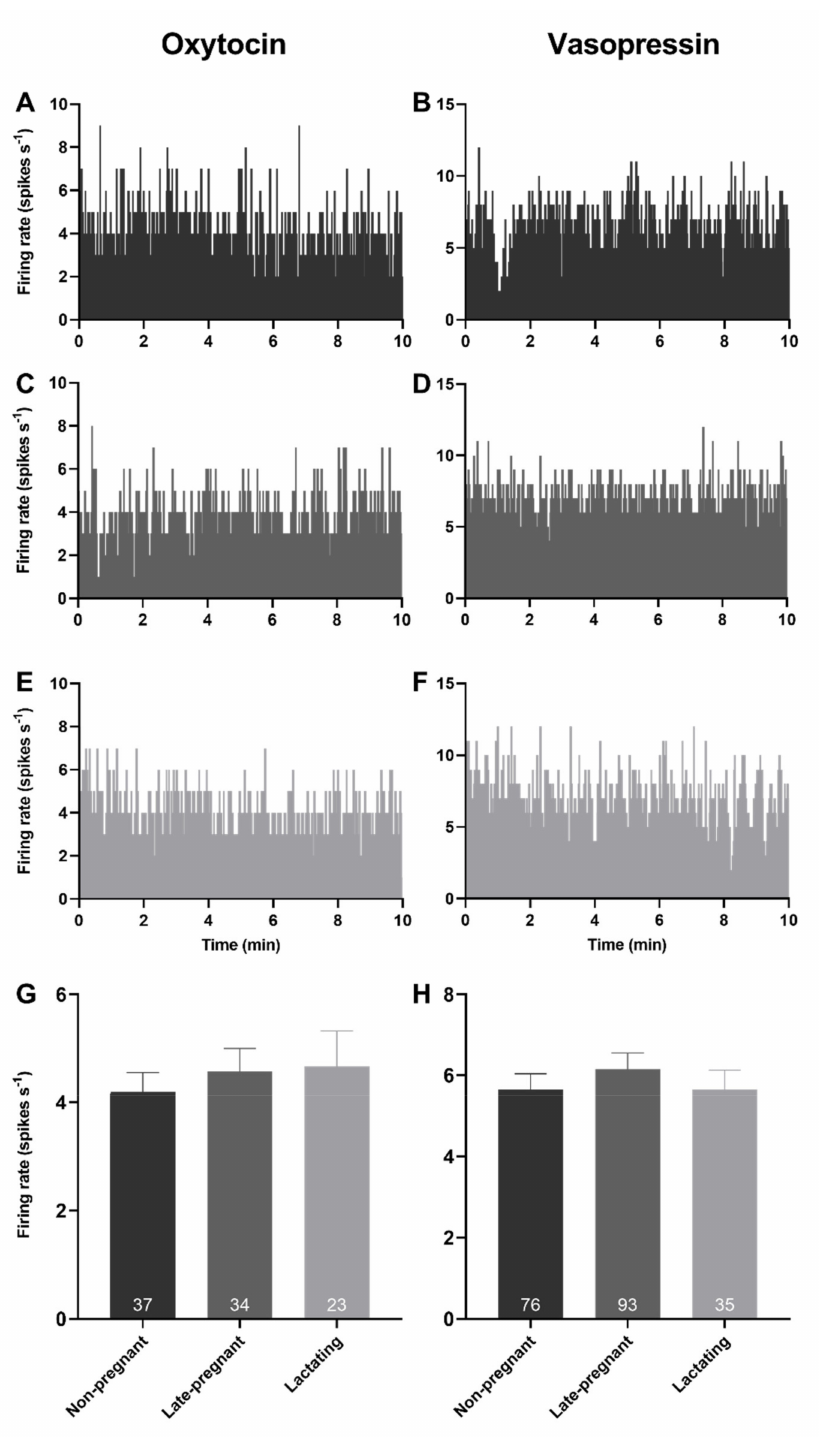
Figure 1. Basal firing rates of oxytocin and vasopressin neurons were not affected by reproductive status. ( A – F ) Example ratemeter recordings of oxytocin neuron ( A , C , E ) and vasopressin neuron ( B , D , F ) firing rate (in 1 s bins) from urethane-anaesthetised non-pregnant ( A , B ), late-pregnant ( C , D ), and lactating ( E , F ) rats. ( G , H ). Mean ( ± standard error of mean (SEM)) spontaneous oxytocin neuron ( G ) and vasopressin (non-phasic and phasic) neuron ( H ) firing rates (averaged over 10 min) in non-pregnant, late-pregnant, and lactating rats. There was no effect of reproductive status on the basal firing rate of oxytocin neurons (one-way ANOVA on ranks; H = 0.35, p = 0.84) or vasopressin neurons ( H = 0.56, p =